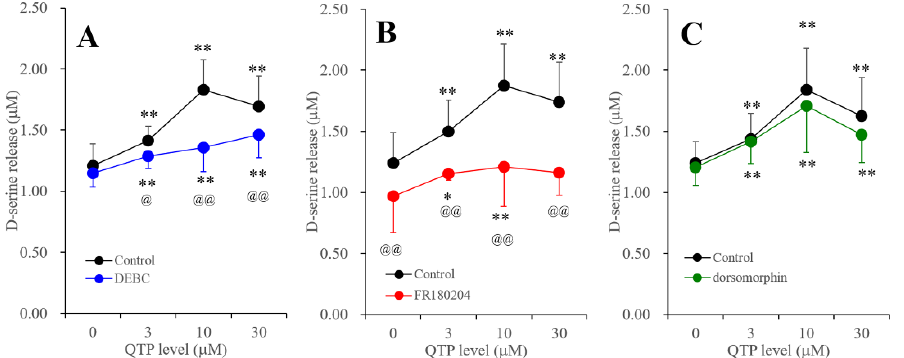
Figure 3. Interaction between subchronic administration of QTP and intracellular signalling inhibi- tors, 10 μM DEBC ( A ), 20 μM FR180204 ( B ) and 10 μM dorsomorphin ( C ) on astroglial ripple-burst evoked D-serine release. Ordinates indicate the mean ± SD of extracellular D- serine level (μM) ( n = 6). Abscissa indicates QTP concentration (μM). * p < 0.05, ** p < 0.01; relative to QTP free, @ p < 0.05, @@ p < 0.01; relative to control (inhibitor free) by two- way ANOVA with Tukey’s post -hoc